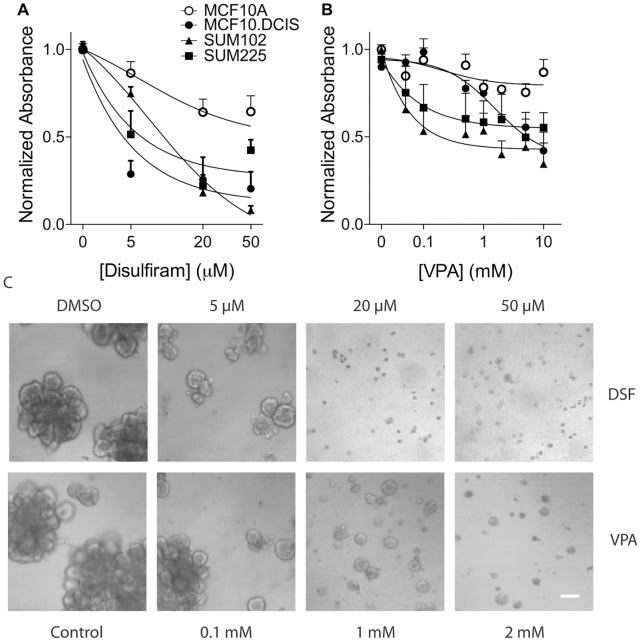
ALDH5A1 as a target in DCIS models.(A, B) Effect of DSF and VPA on proliferation of MCF10A (open circles), MCF10.DCIS (closed circles), SUM102 (triangles) and SUM225 (squares) 3D rBM cultures. Cells were incubated for 72 hours with the indicated concentrations of drugs or with DMSO as a vehicle control and subjected to an MTT assay. Sigmoidal dose-response curves were plotted using nonlinear regression analysis. Data represent the mean ± SEM of three independent experiments (each performed in triplicate). (C) Effect of DSF and VPA on 3D rBM cultures of SUM102-mRFP cells. Cells were incubated for 8 days with the indicated concentrations of drugs or with DMSO as a vehicle control and DIC images are shown. Size bar, 90 µm.